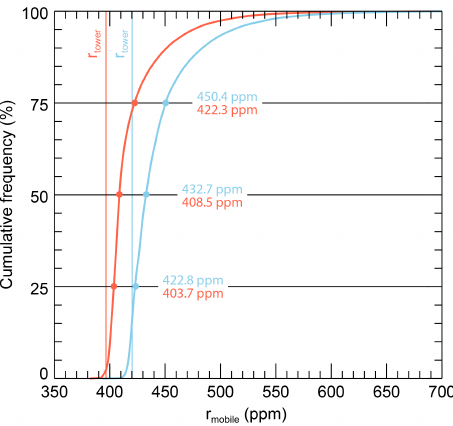
Figure 3. Cumulative frequency distribution for raw 1s r measured by all five mobile systems in the summer (red) and winter (blue) campaign. The thin vertical lines correspond to the average r on top of the tower during the period of the campaign. The coloured num- bers on the horizontal lines refer to the 25, 50, and 75% percentiles for summer (red) and winter